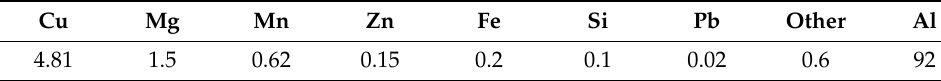
Table 1. Chemical composition of the AA 2024 base metal (%).